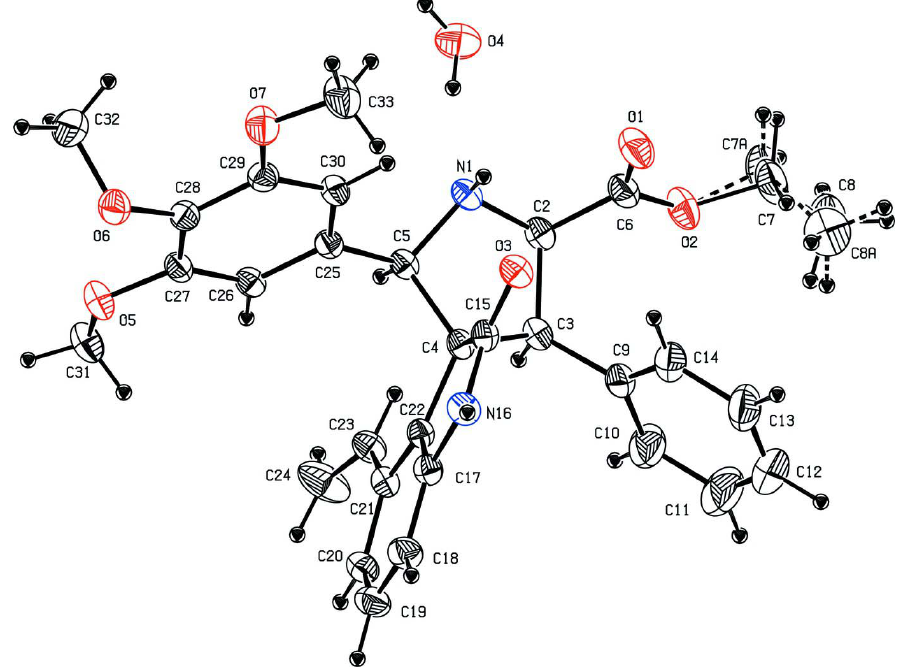
The molecular structure of the title compound, showing 30% probability displacement ellipsoids. Both disorder components are